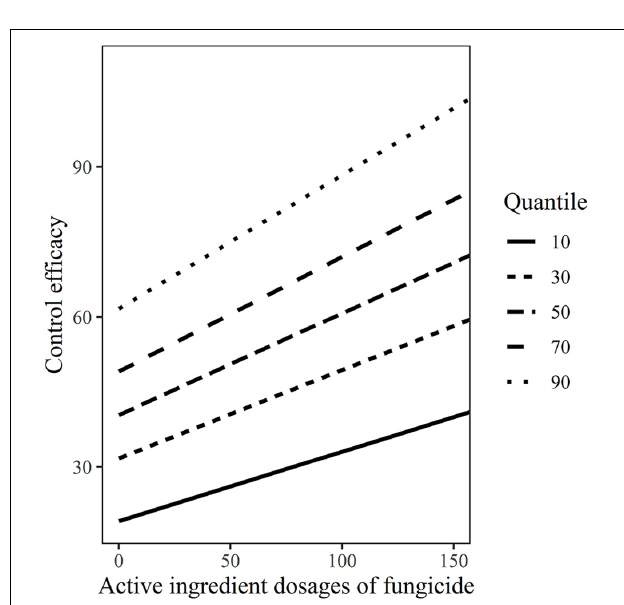
FIGURE 4 | The variability control efficacies with active ingredient dosages of fungicides based on the10, 30, 50, 70, and 90% quantile models.